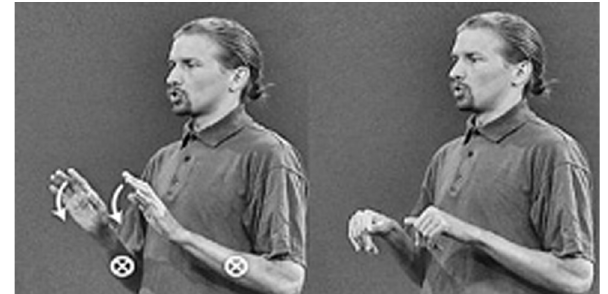
Figure 2: OLI ( Suvi 2003 [ Finnish Sign Language dictionary ] : entry 219 ) .